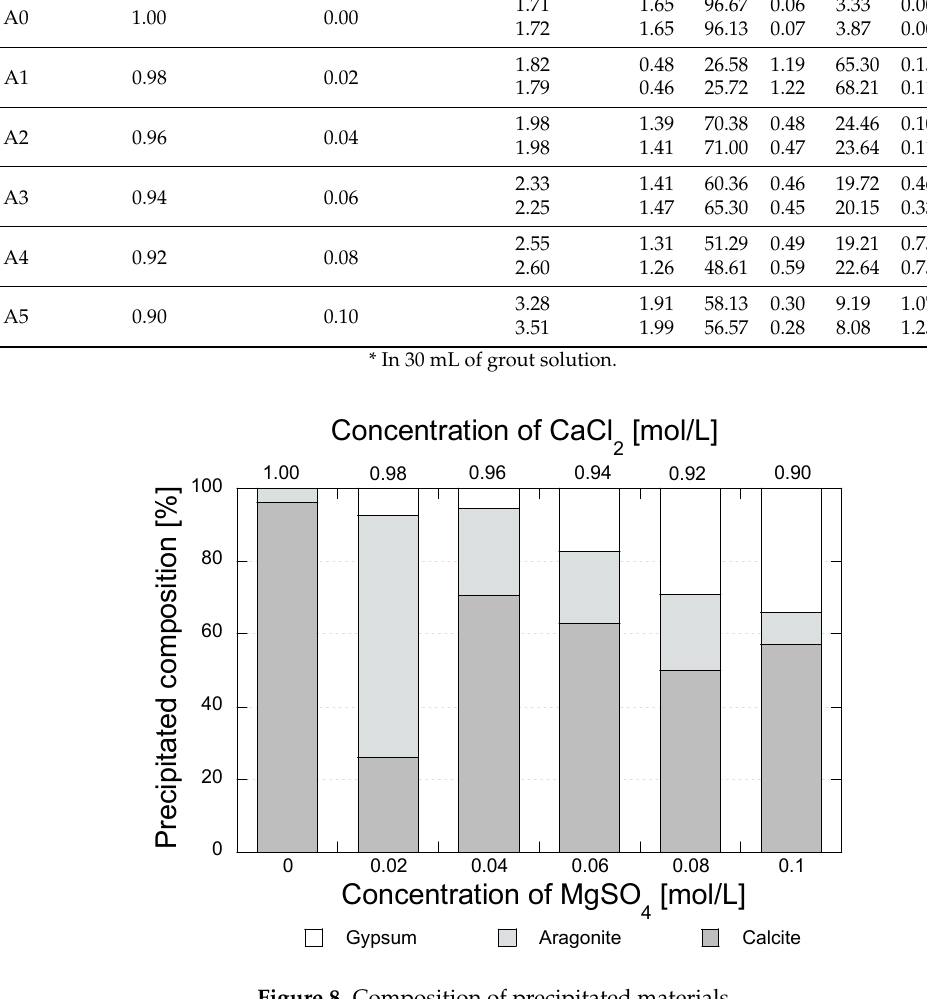
Figure 8. Composition of precipitated materials.